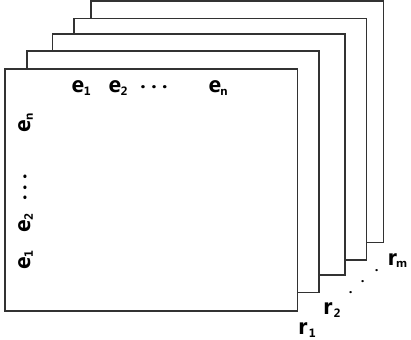
Figure 3. A tensor model of knowledge